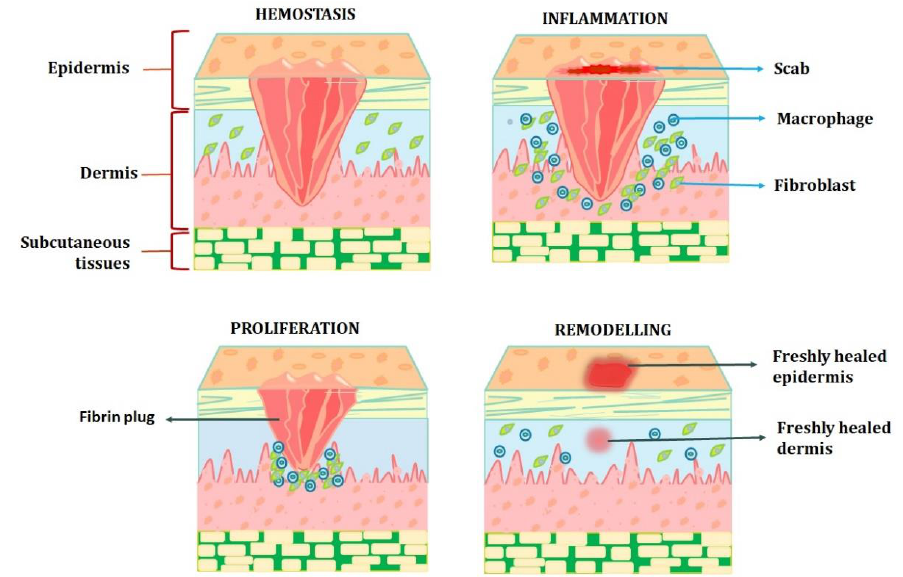
Figure 1. Physiology of wound healing. Haemostasis: The immediate response to a surgical injury is the vasoconstriction of blood vessels at the point of injury. Inflammatory process: brings nutrients to the area of surgery, removes debris and bacteria, and provides stimuli for wound repair. Proliferation: involves processes of angiogenesis, granulation tissue production, collagen deposition, and epithe- lialisation. Remodelling: Type 1 collagen replaces the type 3 collagen found in granulation tissue, and a scar